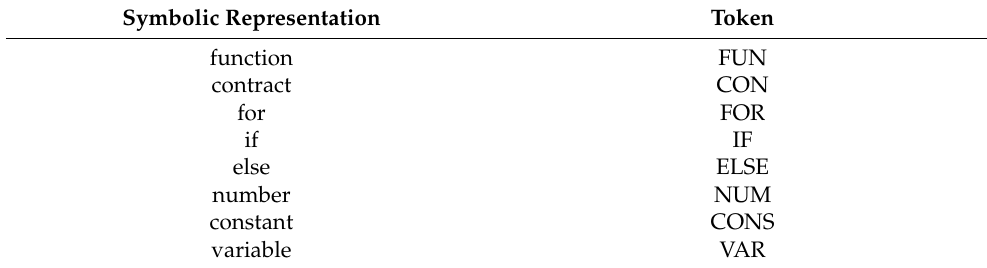
Table 1. The typical Solidity symbol corresponds to the token representation. Symbolic Representation Token function FUN contract CON for FOR if IF else ELSE number NUM constant CONS variable